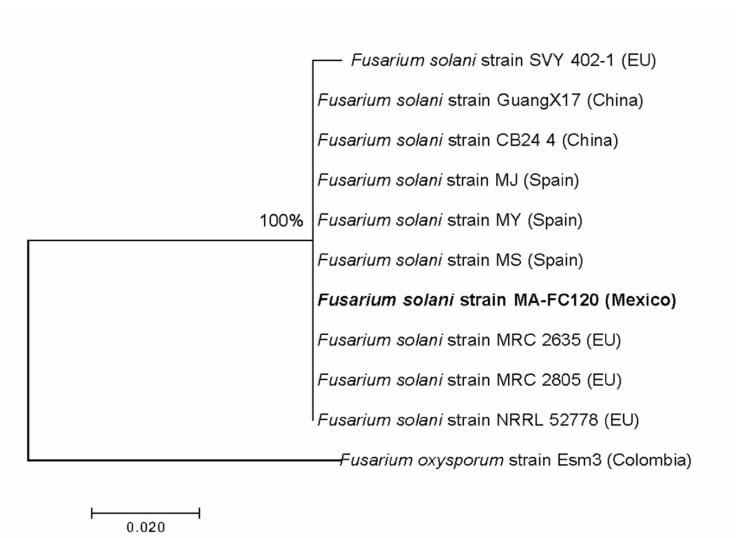
Figure 2. The optimal tree with the sum of branch length = 0.1818 is shown. The tree is drawn to scale, with branch lengths in the same units as those of the evolutionary distances used to infer the phylogenetic tree generated from concatenated ITS/EF-1 α sequences. Fusarium oxysporum was used as the outgroup. The MA-FC120 strains obtained in this study are shown in bold black.